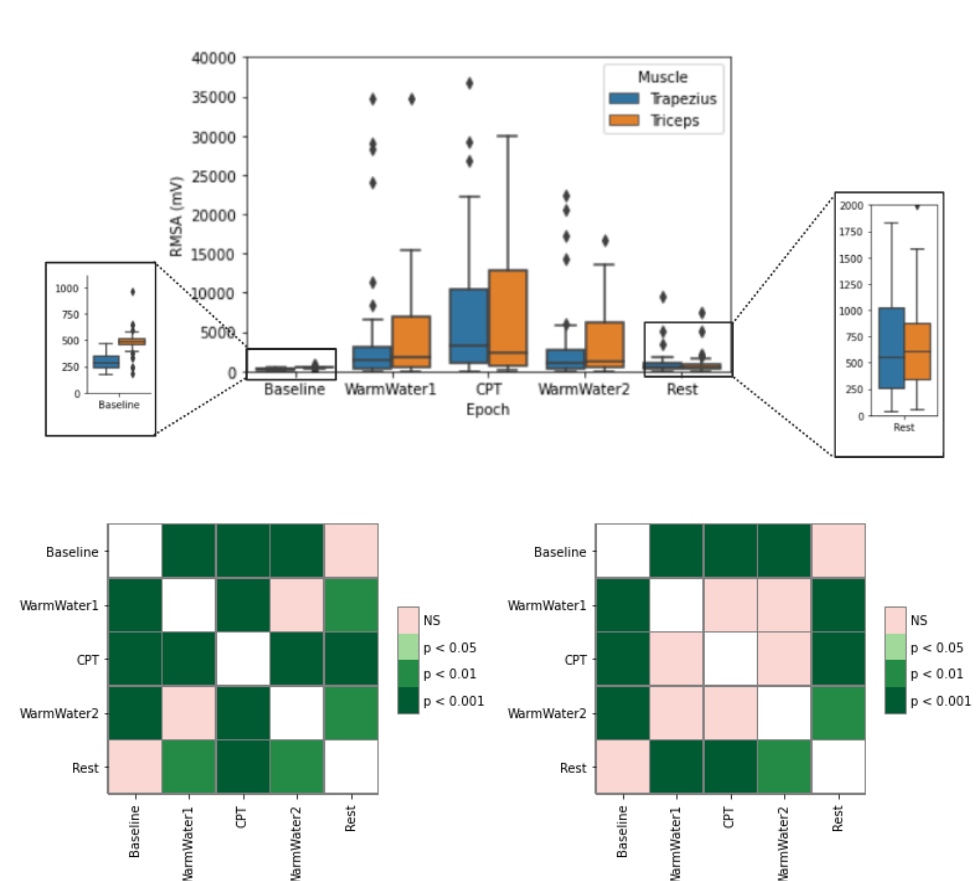
Figure 10. Boxplot of RMSA for the trapezius and triceps muscle ( top ) with respective statisti- cal analysis with p -values, with Bonferroni correction, for the trapezius ( bottom left ) and triceps ( bottom right ). The (cid:5) stands for